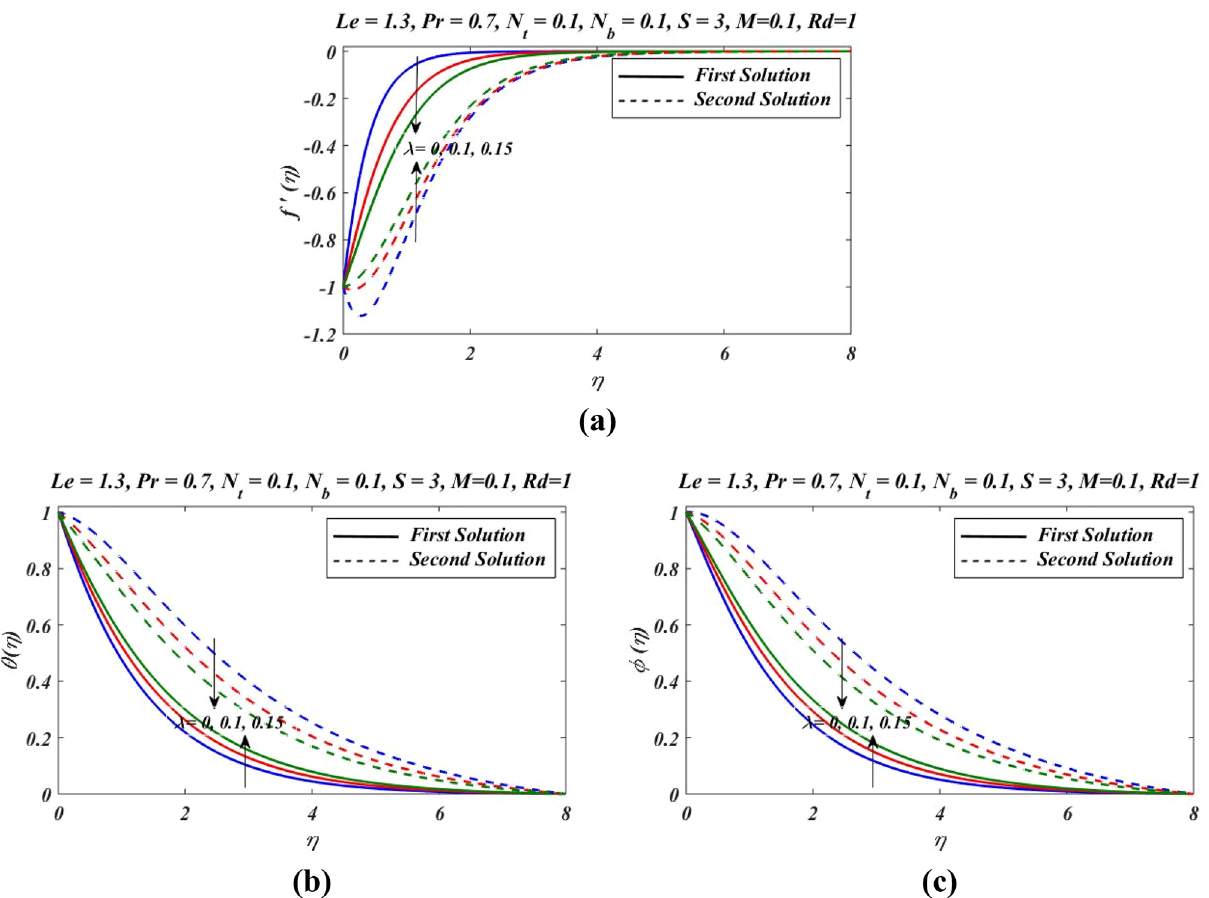
Figure 3. Outcomes of (cid:31) on ( a ) velocity, ( b ) temperature and ( c ) nanoparticles volume fraction.